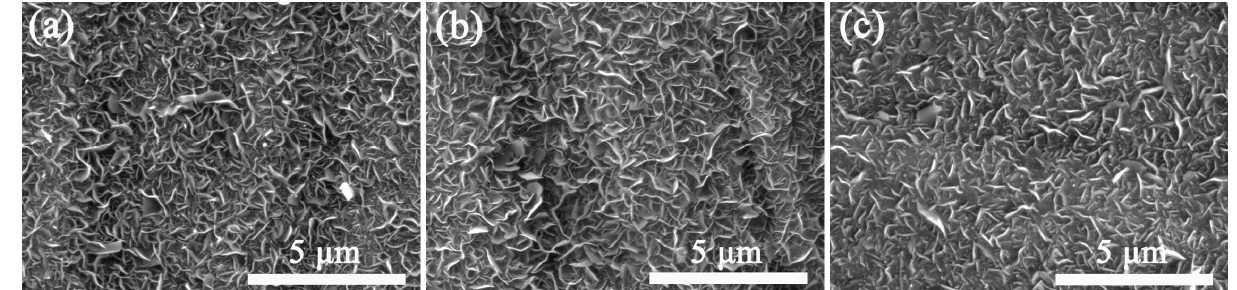
Figure 6. SEM images of the VGNs/CF composite films obtained by heating the 0.4 g/mL precursor solution at 850 °C for different growth times of ( a ) 2 h, ( b ) 3 h, and ( c ) 4 h, respectively.